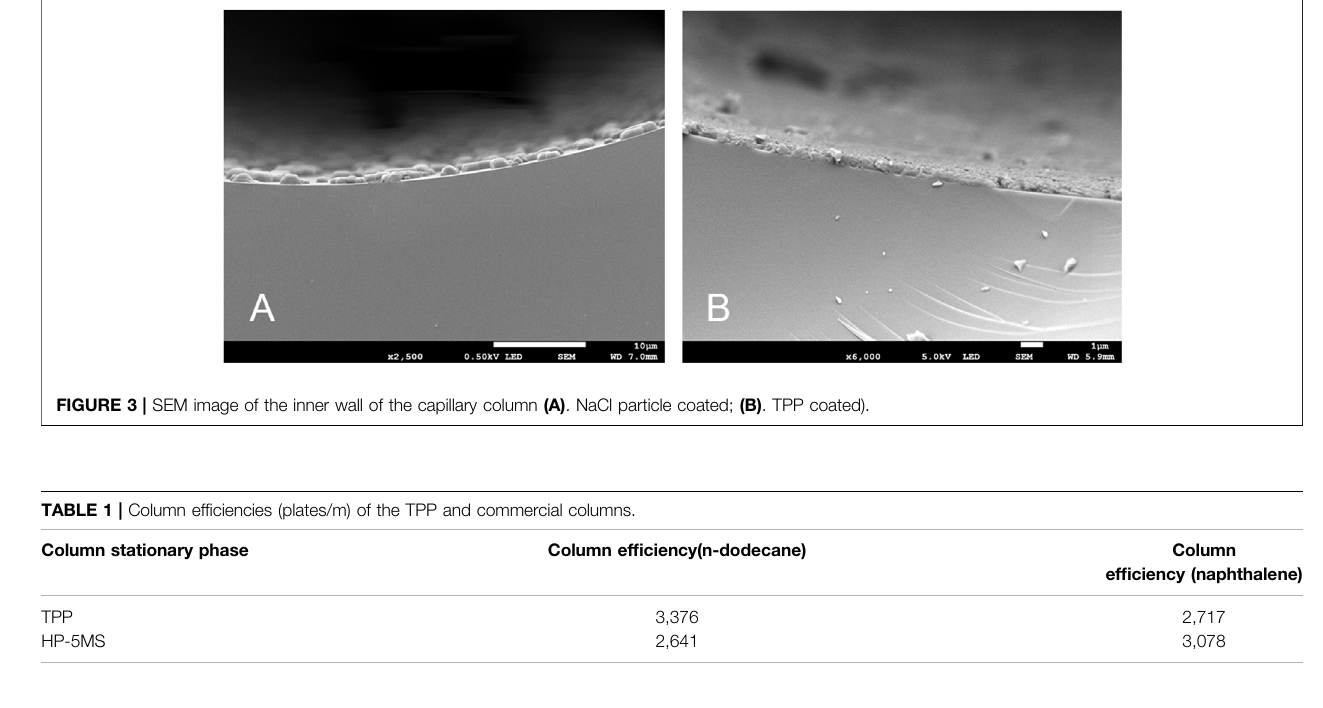
GC column in terms of the peak shapes, chromatographic parameters, and elution order for the 12 analytes. The chromatograms for the Grob mixture acquired using the TPP and HP-5MS columns are shown in Figure 4 . It can be seen that the TPP column gave baseline separation between most of the analytes and sharp symmetrical peaks for most of the analytes except 1,3-butanediol (peak 1), 2-ethylhexanoic acid (peak 8), and dicyclohexylamine (peak 11). These three compounds are strong proton donors, which would have caused slight peak